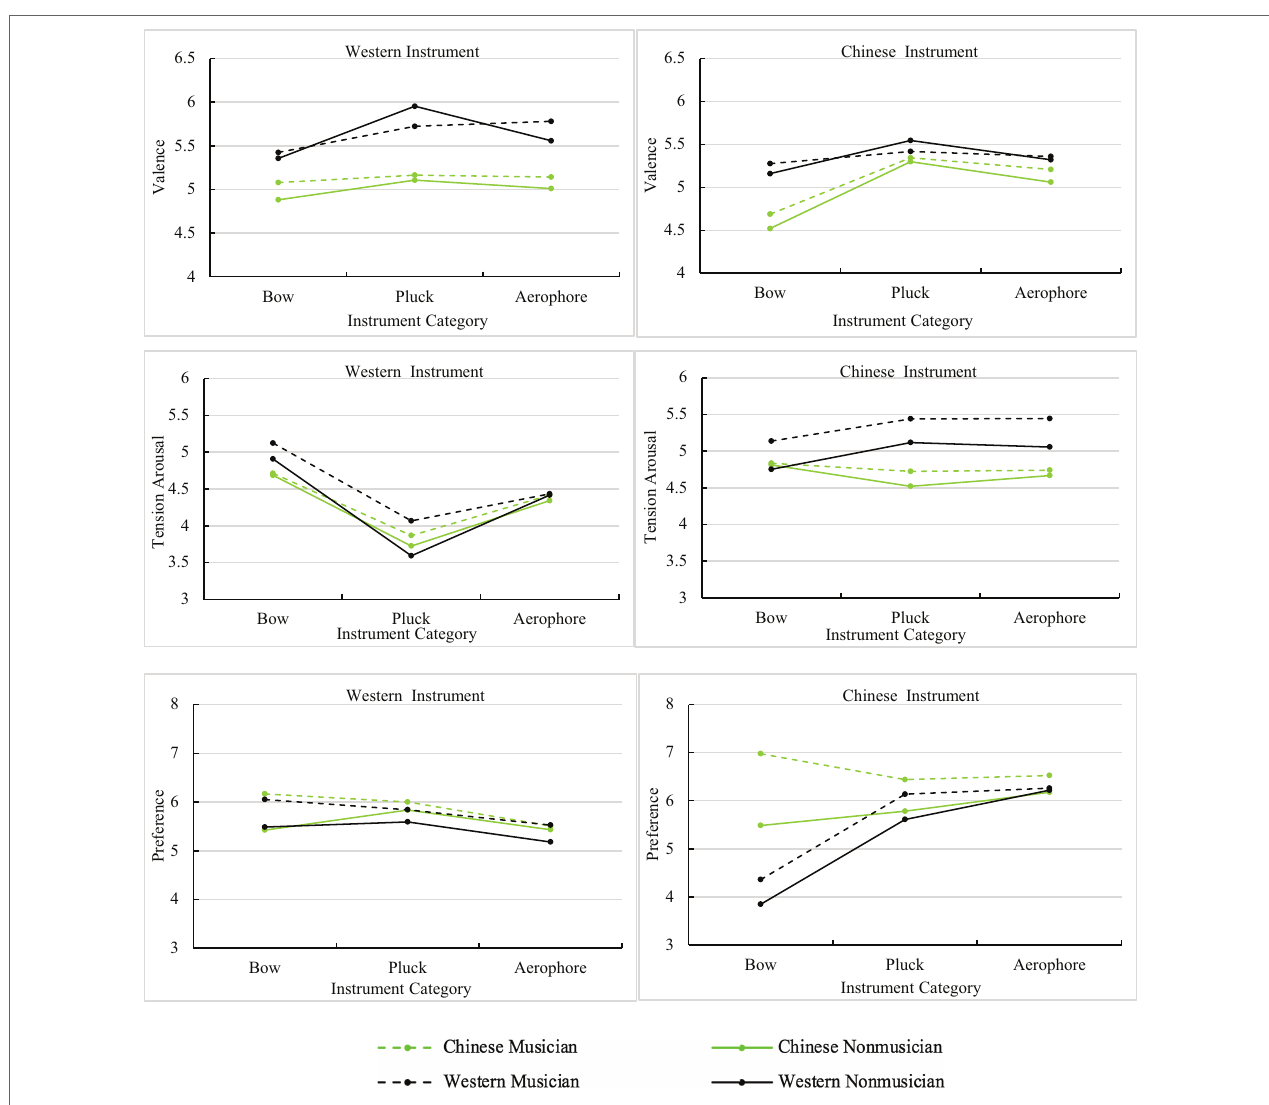
FIGURE 4 | The results of the three-way interaction effect between instrument category, instrument culture, and listener group on valence, tension arousal, and